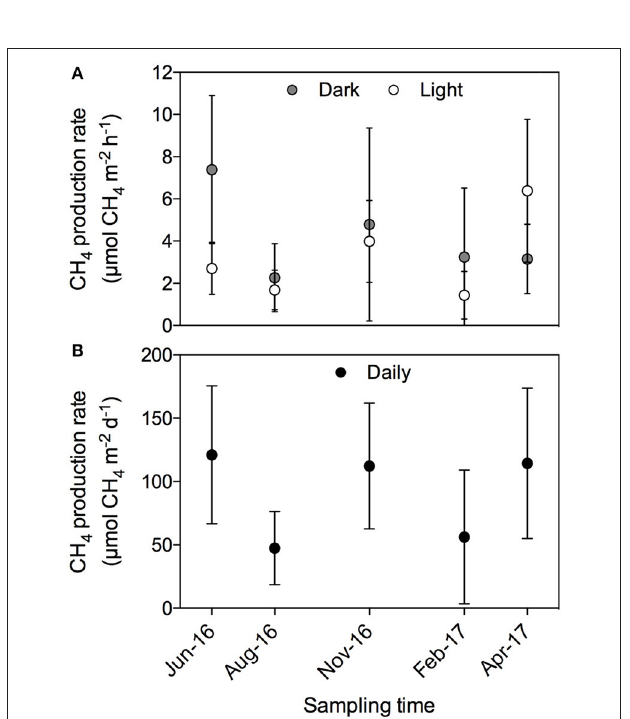
FIGURE 5 | CH 4 production rates measured periodically during 1 year on Enhalus acoroides seagrass meadow (Station S5). (A) CH 4 production rates measured during light (open circles) and dark (gray circles) conditions. (B) Daily CH 4 production rates.